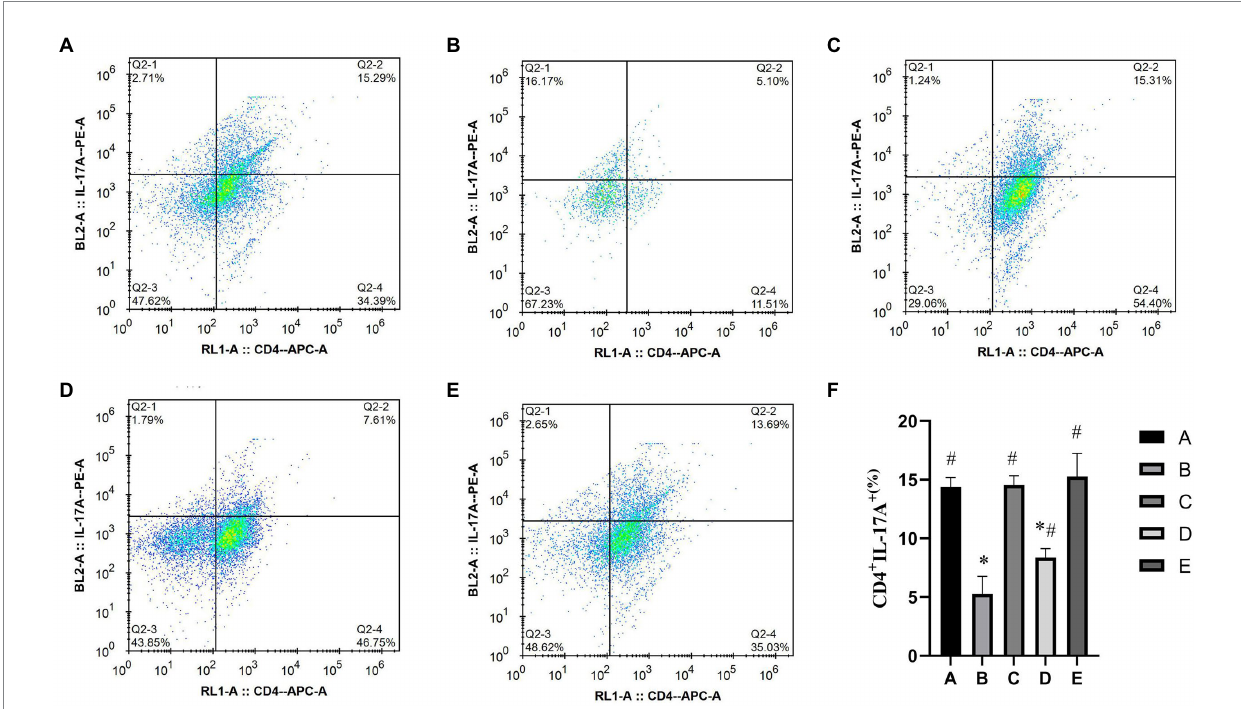
FIGURE 5 Effects of CSPCM on the percentage of Th17 cells in Mesenteric lymph nodes. (A) The percentage of Th17 cells in group A. (B) The percentage of Th17 cells in group B. (C) The percentage of Th17 cells in group C. (D) The percentage of Th17 cells in group D. (E) The percentage of Th17 cells in group E. (F) Effect of CSPCM on percentage of Th17 cells in each